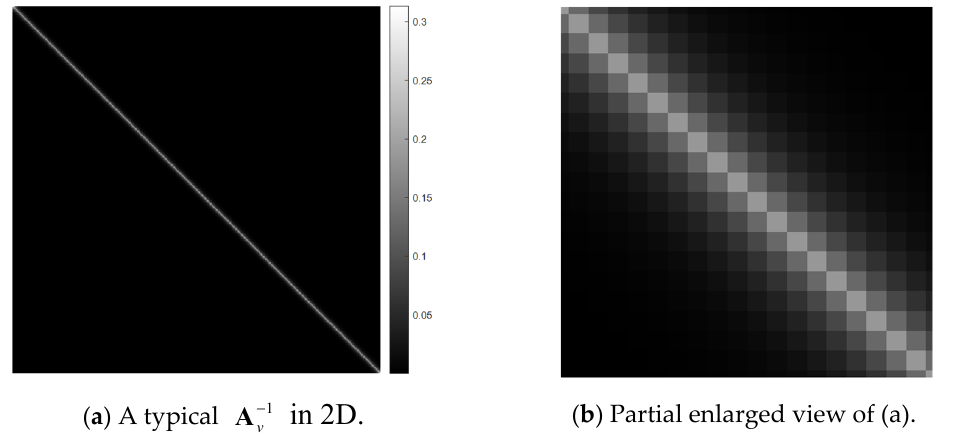
− A ( M = 480, N = 720, and 7 λ= ), where v